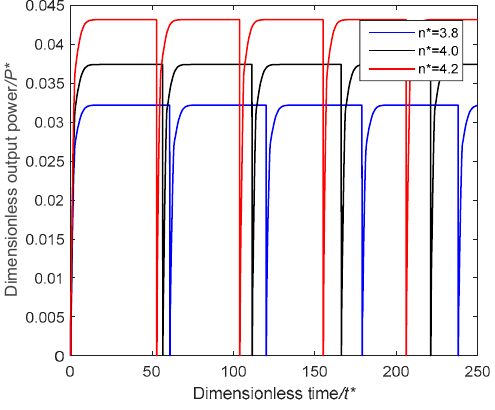
Figure 11. Dimensionless output power–time curves of the power system. Appl. Sci. 2018 , 8 , x FOR PEER REVIEW